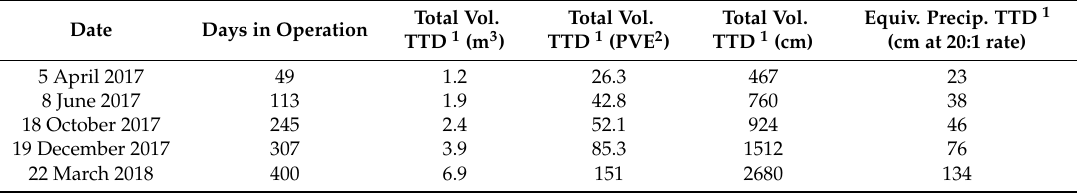
Table 3. Summary of cumulative hydraulic loading by sampling date *